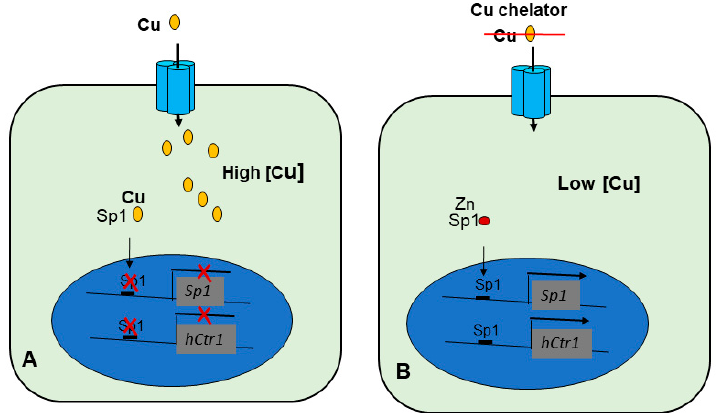
Figure 2. Models depicting regulation of Sp1 and hCtr1 expression by different Cu(I) levels. ( A ) Under high Cu(I) levels, Cu(I) displaces Zn(II) from the Zinc fingers of Sp1, resulting in inactivation of Sp1 and its inability for transcriptional regulation of Sp1 and hCtr1 . ( B ) In contrast, under low Cu conditions, Sp1 is capable of binding to the promoters of Sp1 and h Ctr1 , and transcriptionally induces their expression.